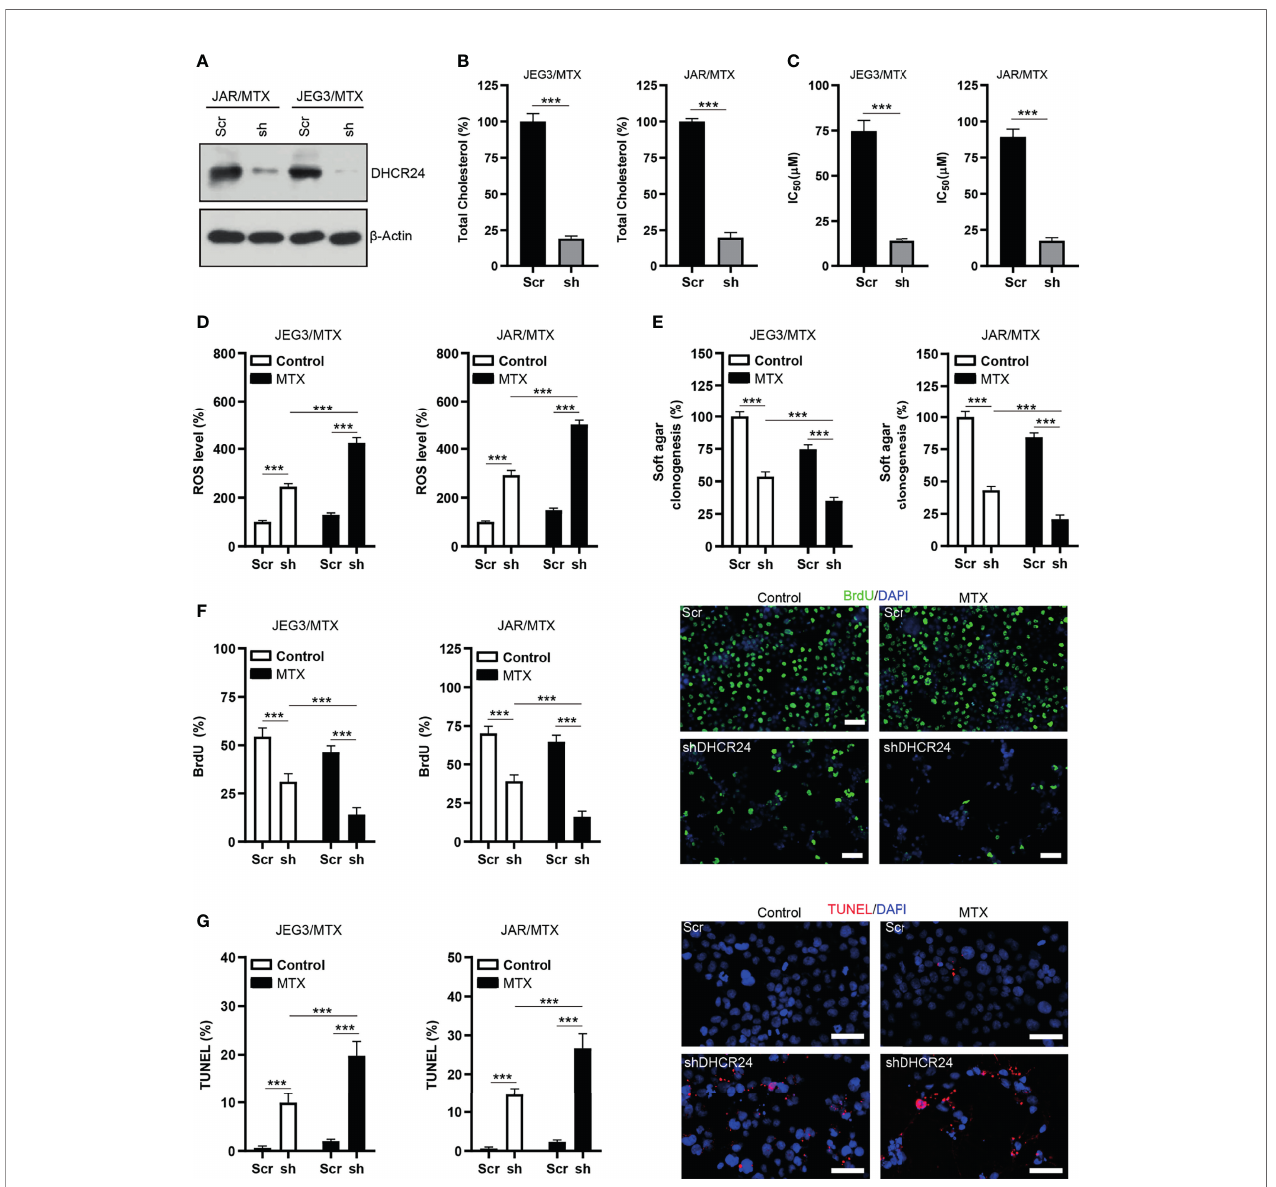
FIGURE 3 | Knockdown of DHCR24 expression in fl uences cellular cholesterol level, ROS accumulation and chemoresistance in MTX-resistant GTN cells. (A) DHCR24 expression was effectively attenuated by shRNA lentiviruses in JAR/MTX and JEG3/MTX cells. (B) Knockdown of DHCR24 reduced cellular cholesterol level in MTX-resistant GTN sublines. n=4, ***P<0.001. (C) Knockdown of DHCR24 increased the chemosensitivity to MTX in JEG3/MTX and JAR/MTX cells. n=4, *P<0.001. (D) Knockdown of DHCR24 increased the accumulation of ROS after MTX treatment (10 m M) for 96 hours in JEG3/MTX and JAR/MTX cells. The ROS level in Scr without MTX treatment was regarded as 100%. n=4, ***P<0.001. (E) Knockdown of DHCR24 impaired clonogenesis after MTX treatment (10 m M) in JEG3/MTX and JAR/MTX cells. The colony formation in Scr group without MTX treatment was regarded as 100%. n=4, ***P<0.001. (F) Knockdown of